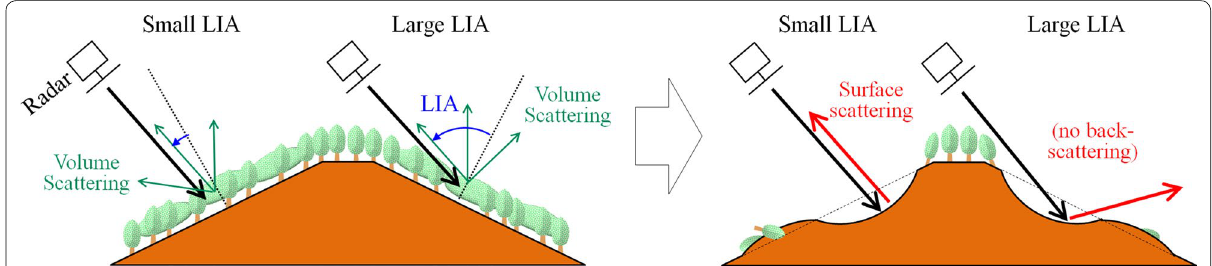
Fig. 1 Schematic illustration of polarimetric scattering mechanisms for the cases of small and large LIA, before (left) and after (right)